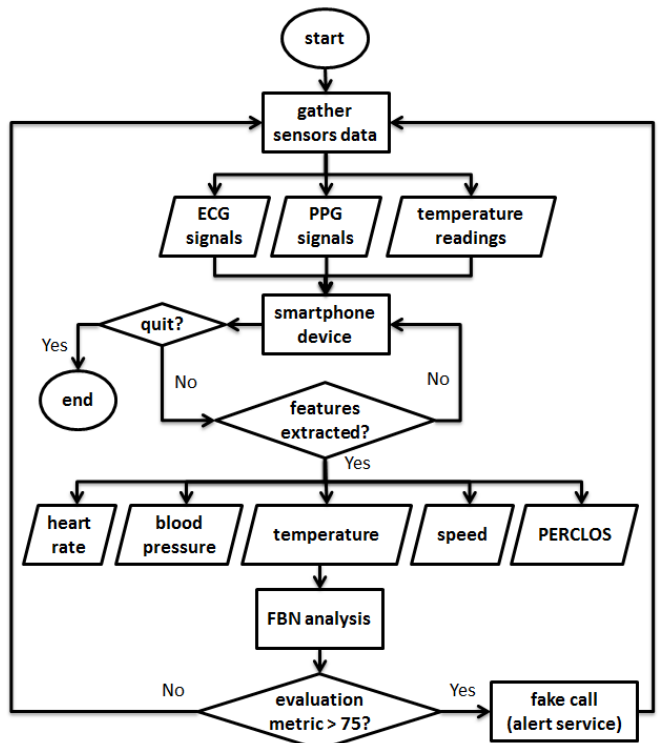
Figure 5. Application flowchart where the application first converts the sensors reading into useful parameters which serves as inputs to Fuzzy Bayesian network and the fake